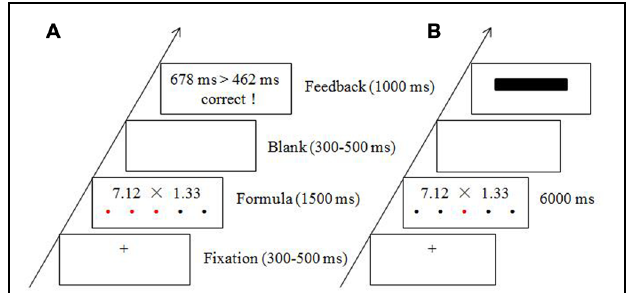
FIGURE 1 | Experimental procedure and sample materials for the stress condition (A) and the control condition